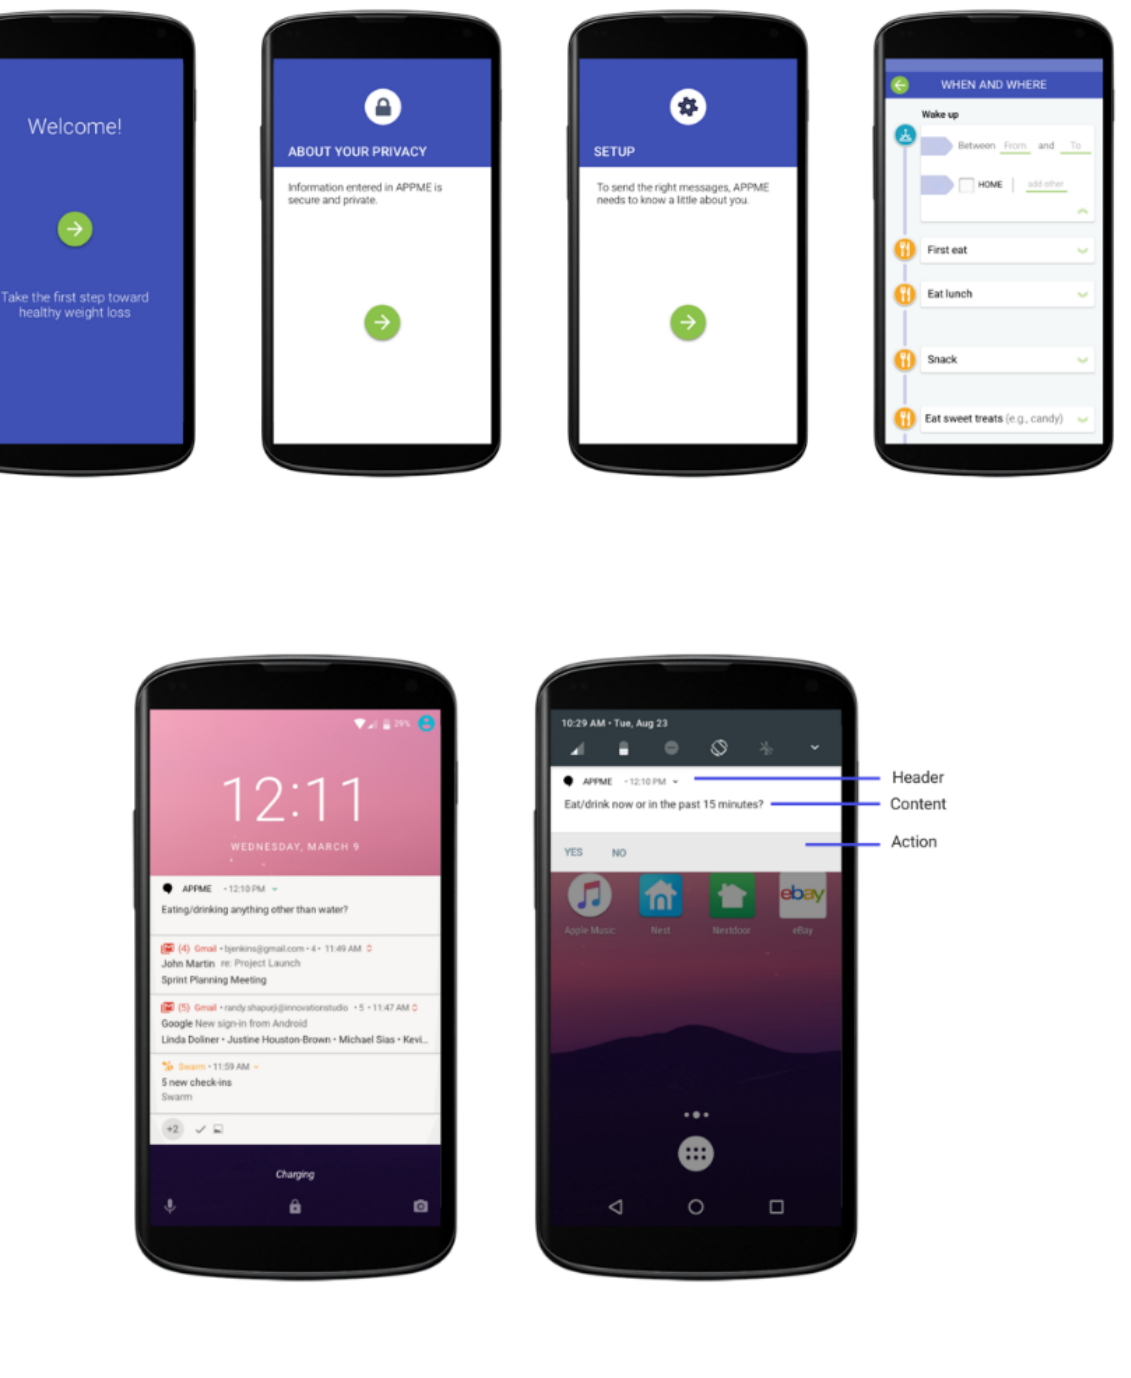
Figure 2. One-time onboarding screens (top) and example ecological momentary assessment question in device’s notification drawer (bottom left) and structure of an example ecological momentary assessment question (bottom